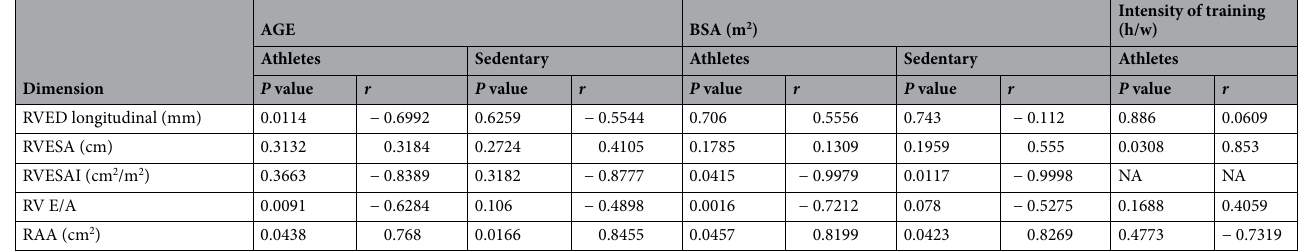
Table 3. Multivariate analysis of ECHO data. Only statistically significant data were shown. NA, not available; h/w, hours/week.